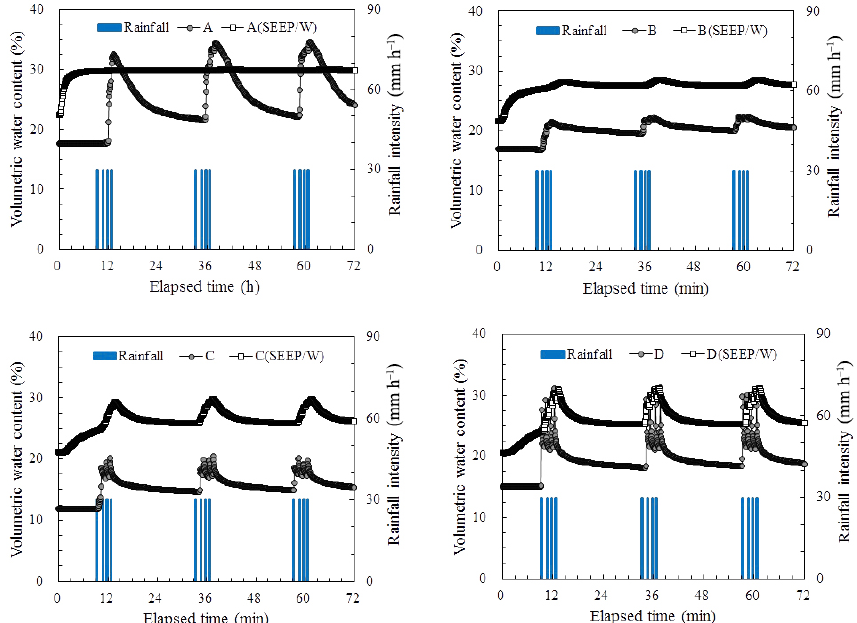
Figure 6. Comparison of volumetric water content of experimental data and results of numerical analysis in the model slope of 50 ◦ inclina- tion.